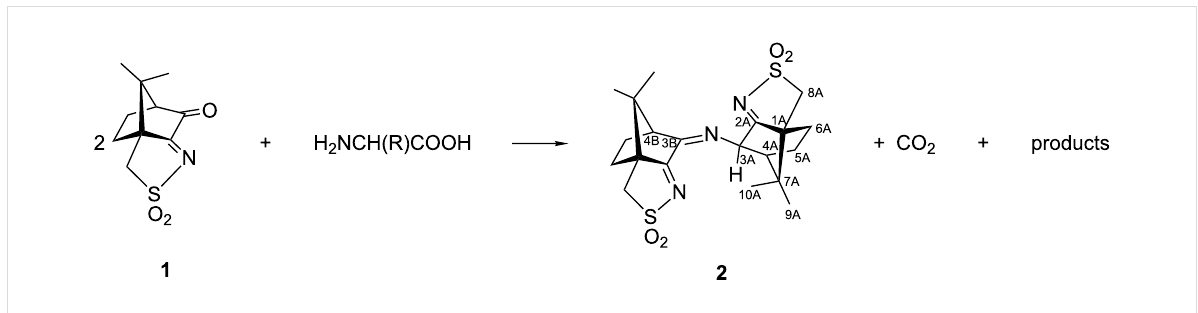
Scheme 1: Formation of 2 from reaction of oxoimine 1 with amino acids (H 2 NCH(R)COOH: R = H, CH 3 , CH 2 Ph, CH 2 CH(CH 3 ) 2 ) and carbon atoms numbering for 2 .